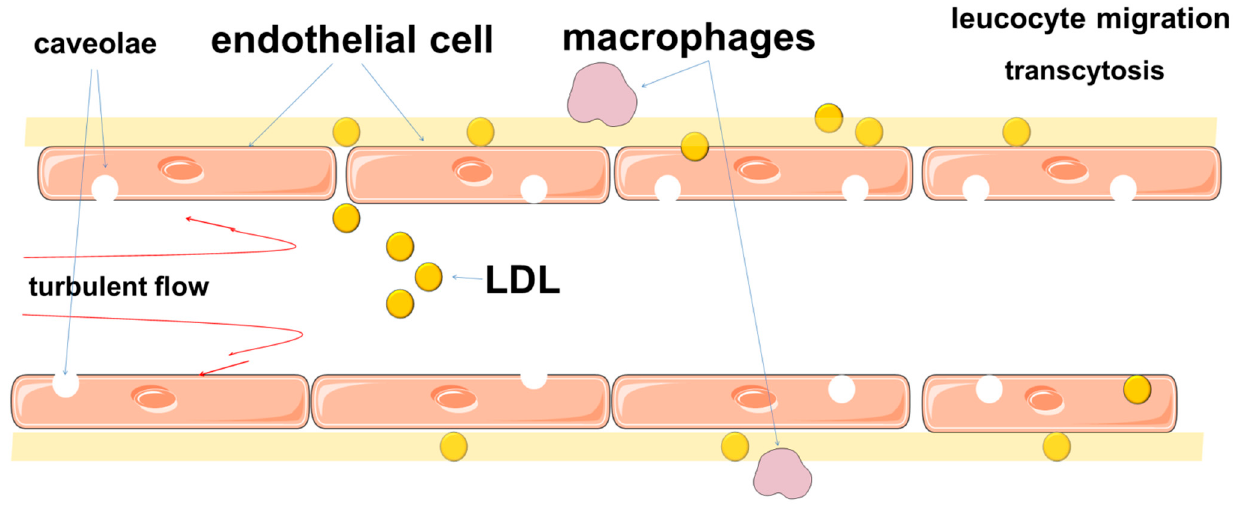
Figure 3. Schematic illustration of transcytosis involving caveolae.